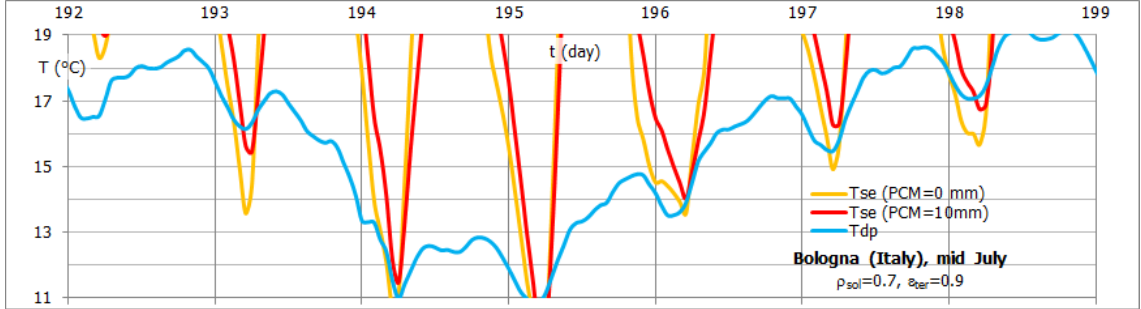
Figure 5. Time evolution patterns of dew point surface (with and without PCM) temperatures: the risk of condensation exists where the surface temperature falls below the dew point